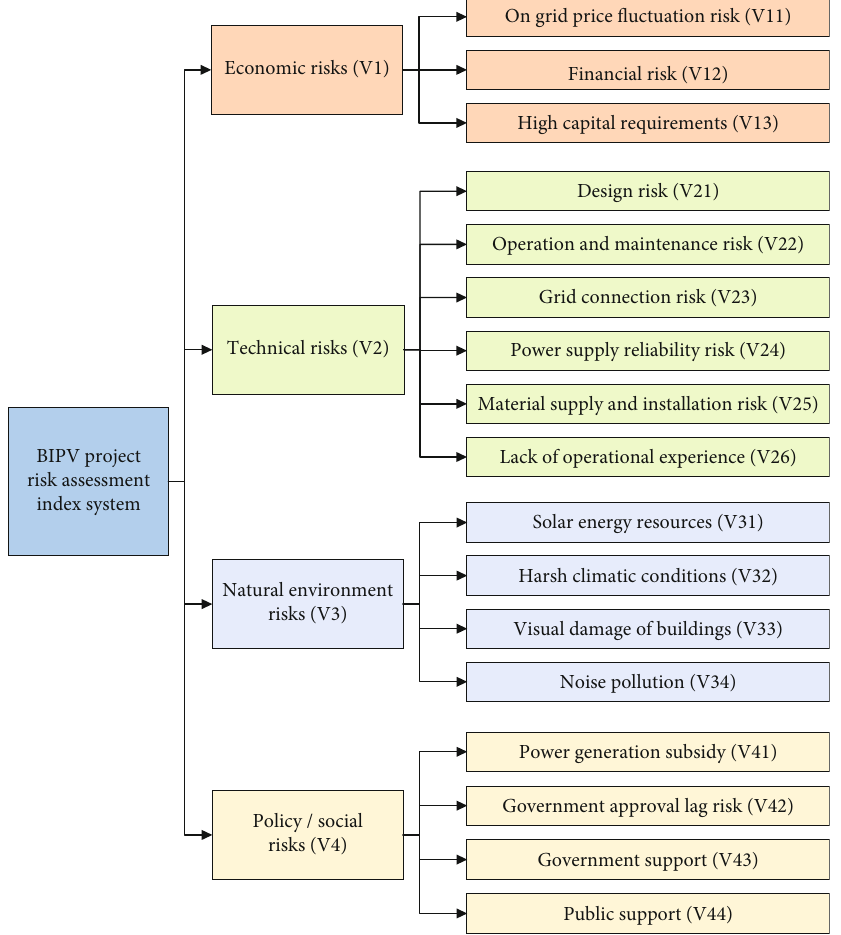
Figure 2: BIPV project risk assessment indicator